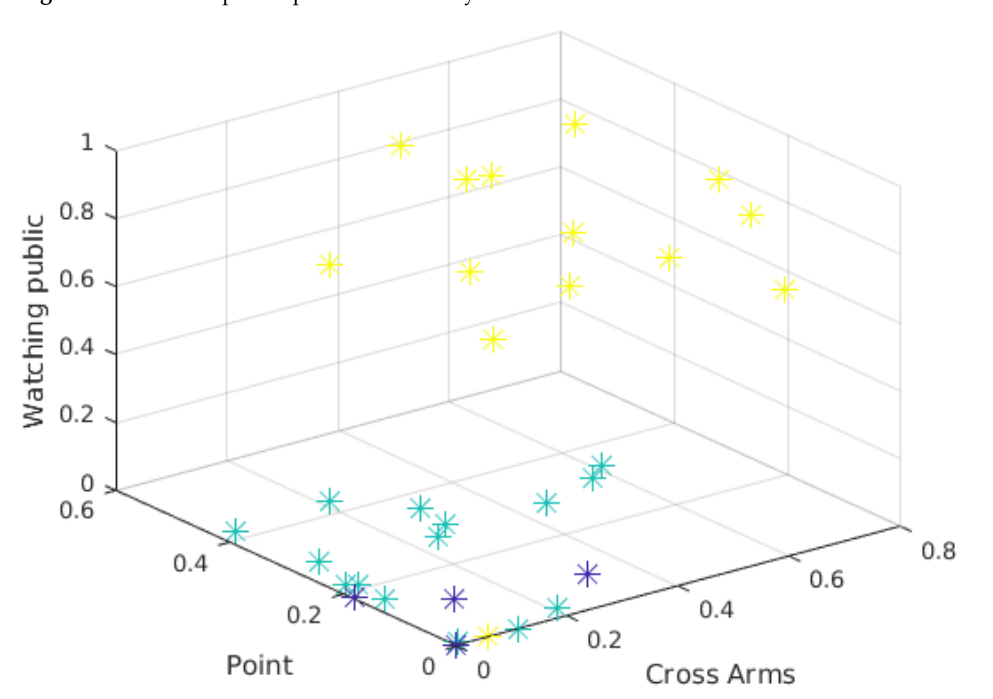
Figure 10. 3D Scatter plot of presentation 3 in year